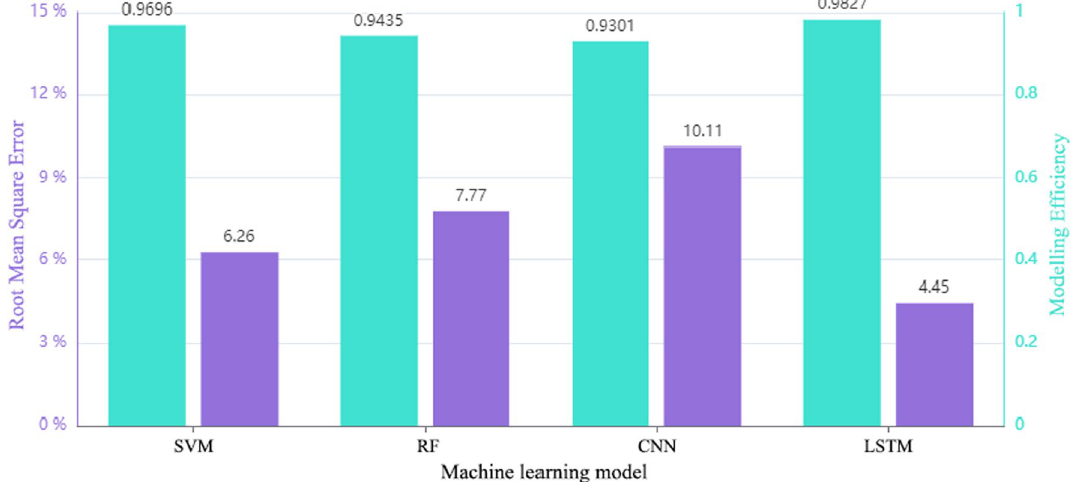
Fig. 5 Comparison of various model